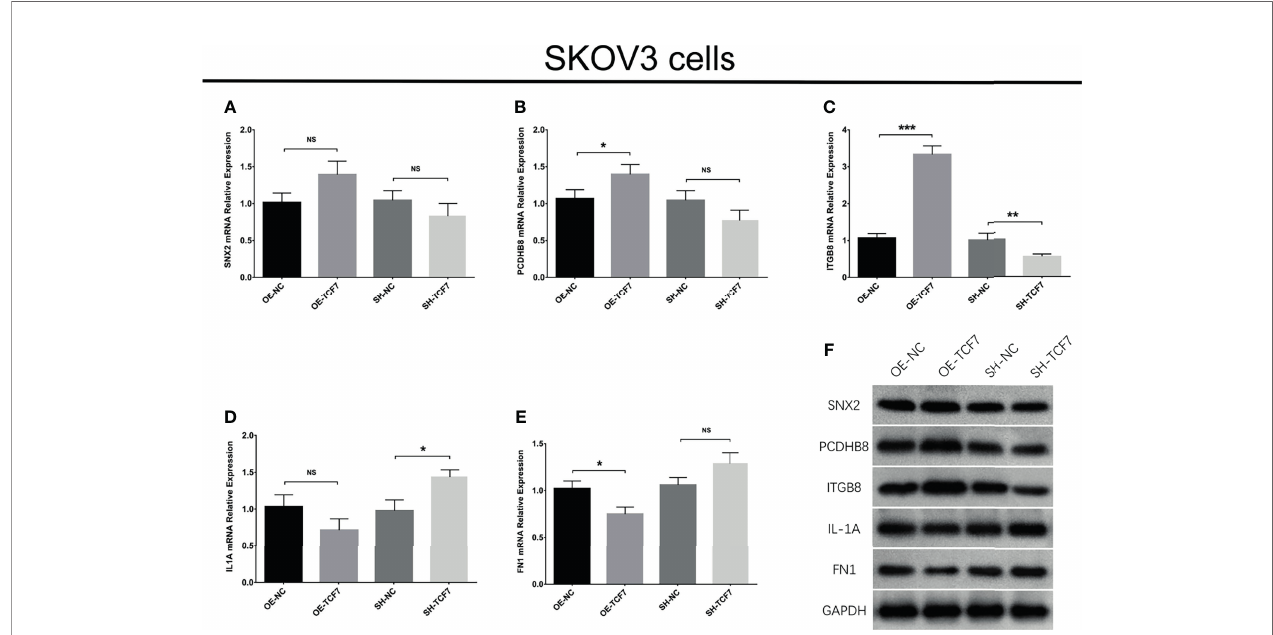
FIGURE 4 | Validation of top 5 DEGs expressions after transfection. SNX2 (A) , PCDHB8 (B) , ITGB8 (C) , IL1A (D) , FN1 (E) mRNA expressions after transfection; and their protein expressions after transfection (F) . Experiments were performed in triplicates. * represented P < 0.05, ** represented P < 0.01, *** represented P < 0.001, ns represented no signi fi